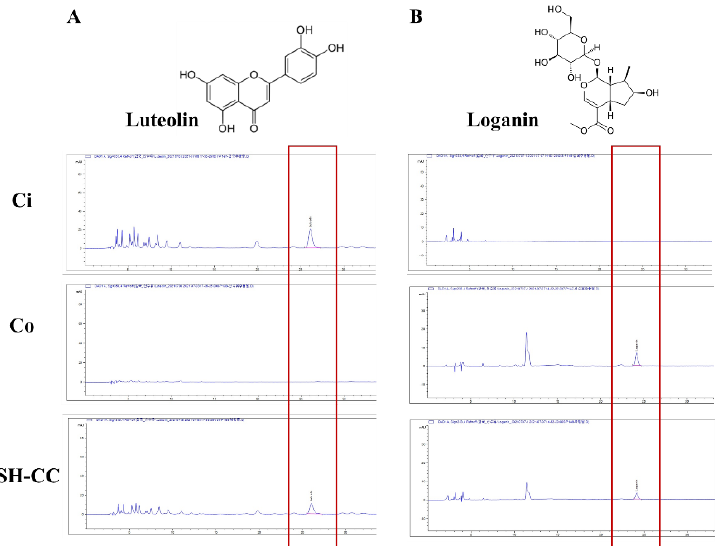
Figure 1. High-performance liquid chromatography analysis of luteolin ( A ) and loganin ( B ) levels in Ci, Co, and FSH-CC.